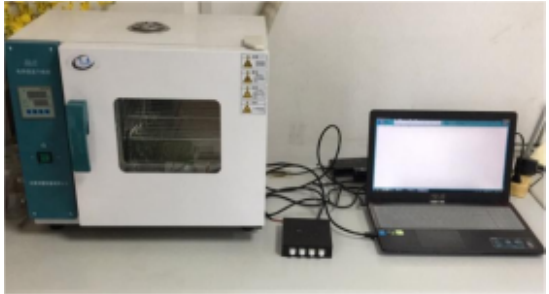
Figure 24. Temperature sensing experimental